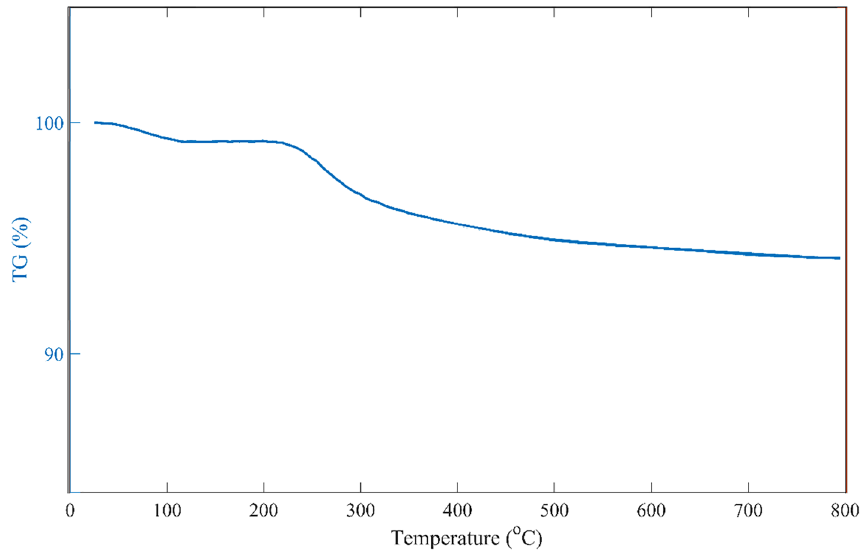
Figure 4. TGA curves of Zn-doped CuFe 2 O 4